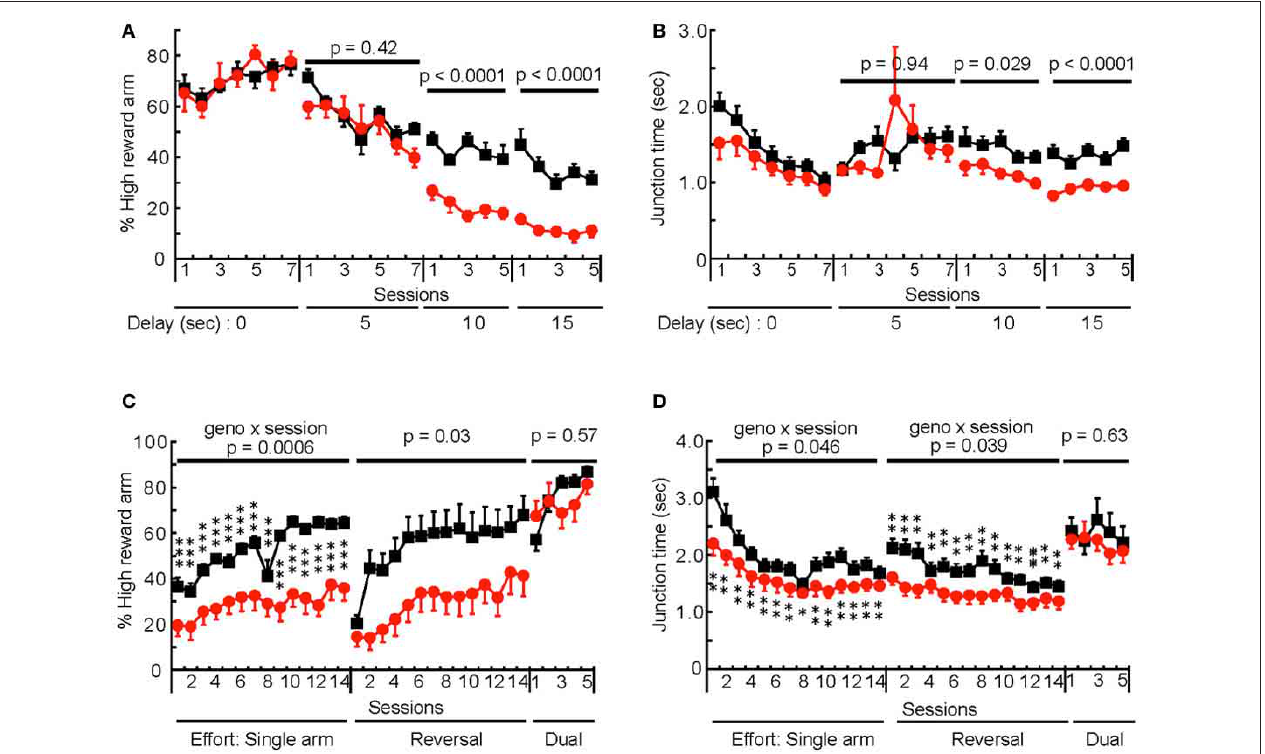
FIGURE 4 | Delay-based and effort-based decision-making in mHb:DTA mice. (A,B) Delay-based decision-making test in mHb:DTA mice